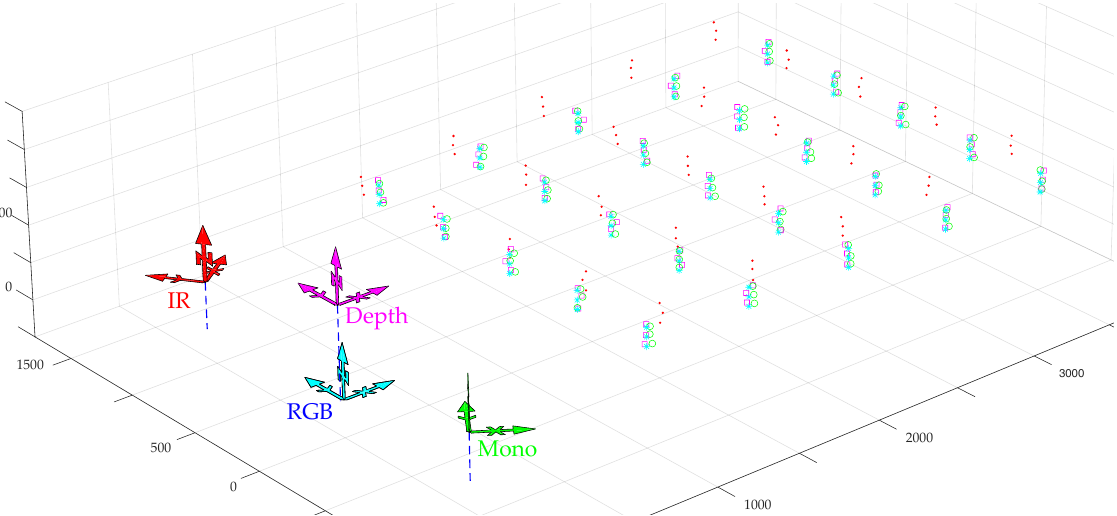
Figure 12. Example of synthetic point clouds with systematic and random errors in a sensor arrangement similar to the one in ATLASCAR2. Units are in